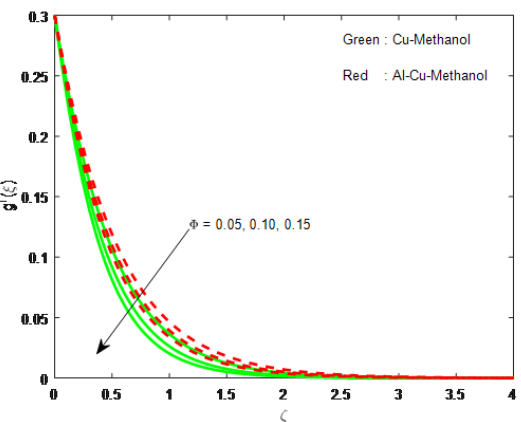
Fig. 21: Impression of m on g (cid:48) ( ξ )